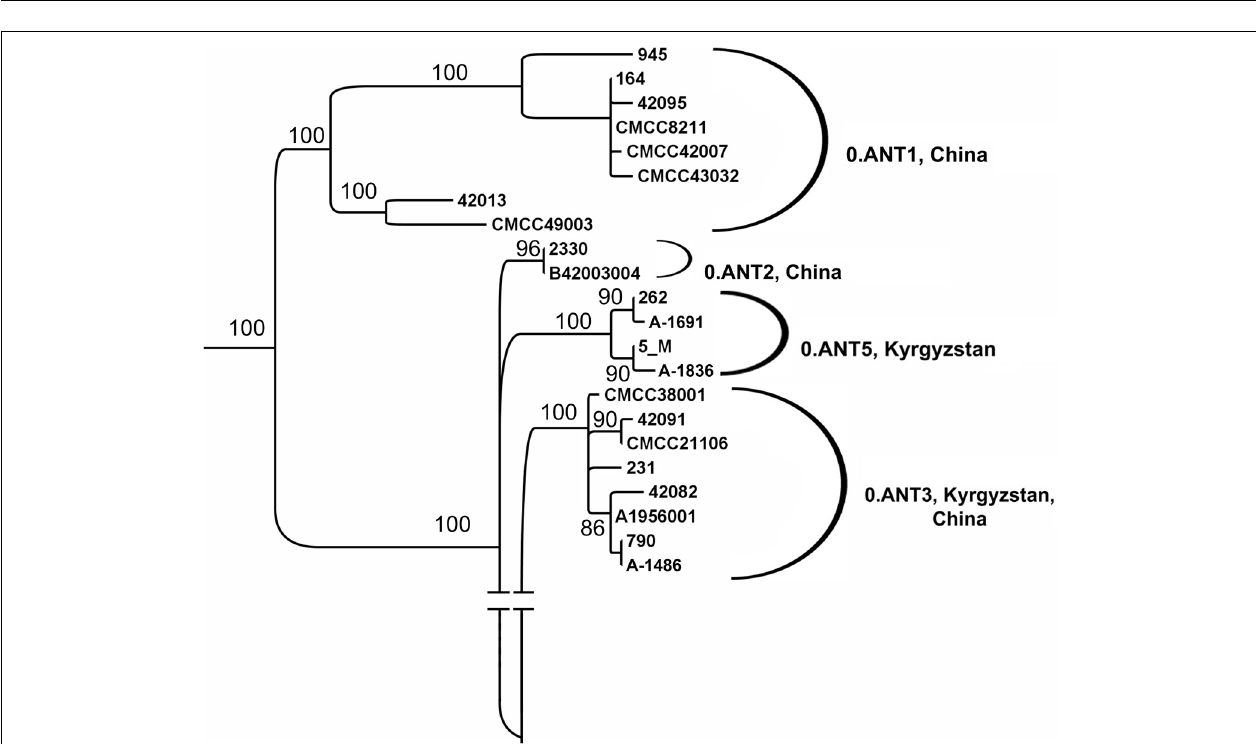
FIGURE 5 | Phylogenetic analysis of Y. pestis strains of antique bv., branch 0.ANT from plague foci of Kyrgyzstan (fragment of the global phylogeny dendrogram of Y. pestis, shown in Figure 2 ). Maximum likelihood tree, PHYML 3.1 software program, HKY85 model and 500 bootstrap replications. Strains: A-1836, A-1691, 231, A-1486, 5M, and 262 are from Tien-Shan and Alay high-mountain foci; other strains (NCBI GenBank) are from China, strain 790 is from Kyrgyzstan.